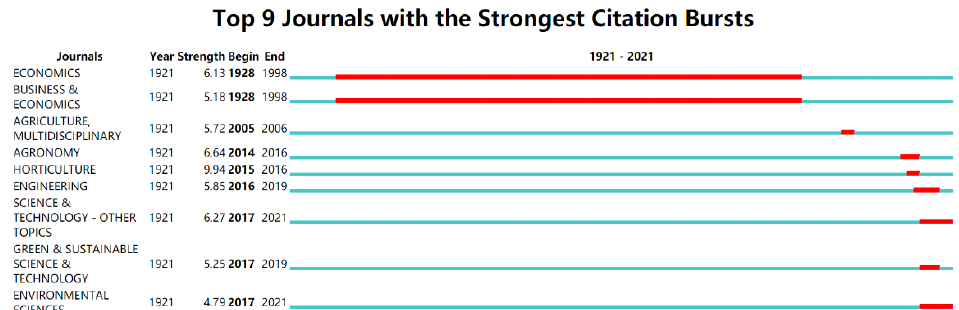
Figure 4. WOS Keyword Co-occurrence Network Diagram.